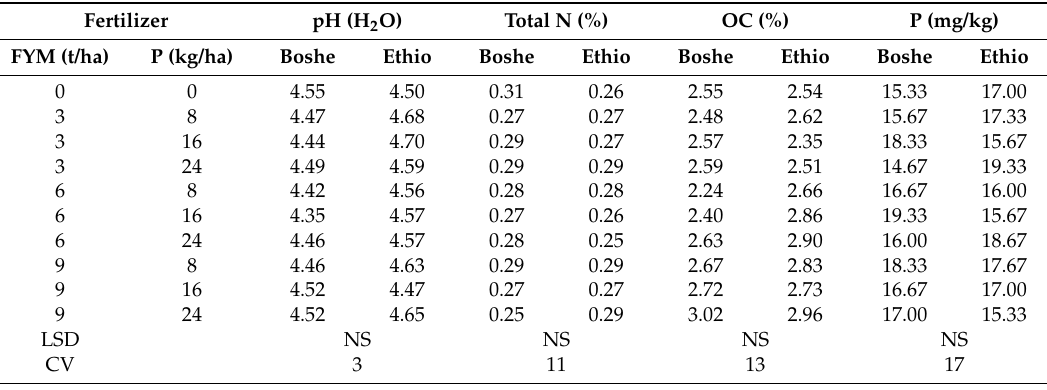
Table 5. The effects of soybean varieties, farmyard manure and inorganic fertilizer application on soil pH, organic carbon, total nitrogen contents and available phosphorus after soybean harvesting in 2014 at Bako, Western